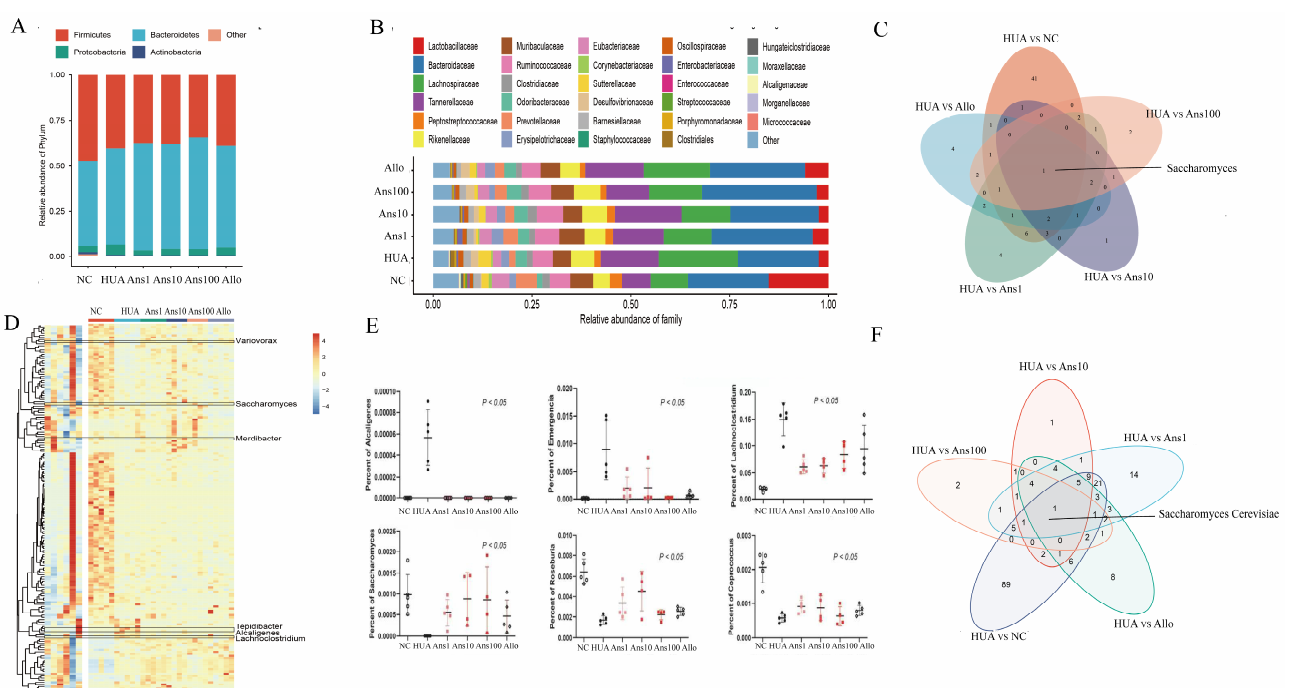
Figure 6. Alterations in the gut microbiota of each group. Abundance distribution: ( A ) phylum level; ( B ) genus level; ( D ) species level; ( E ) The three differential genus with the highest and lowest abundance in the HUA group compared to the Anserine and allopurinol intervention groups. ( C , F ) Common genus and species shared with five compared groups ( p < 0.05).